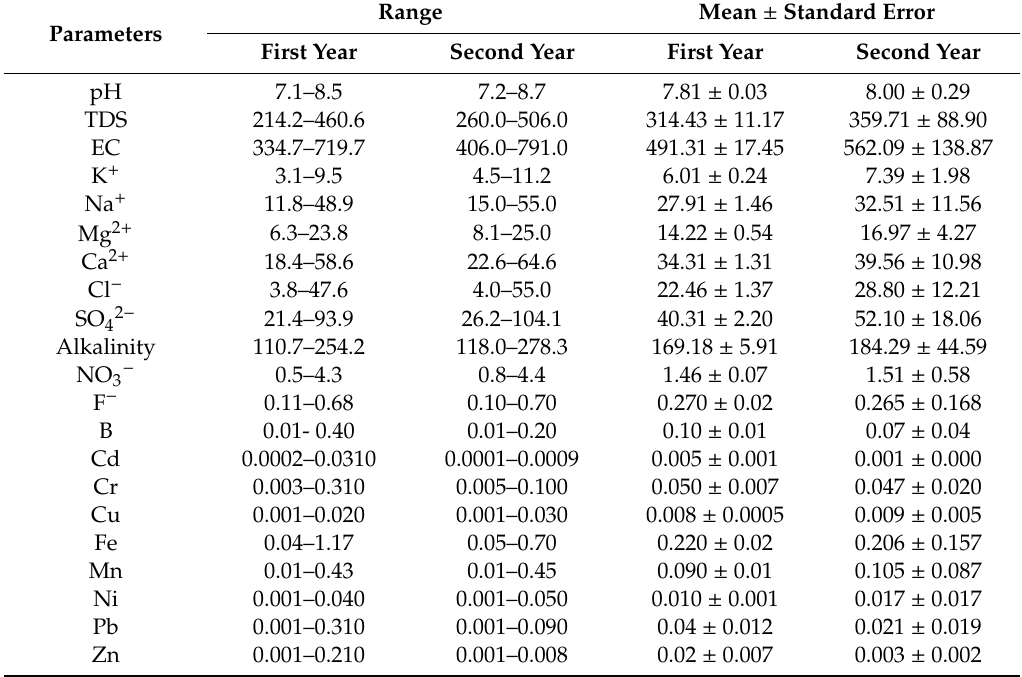
Table 2. Statistical analysis of the physicochemical parameters over two